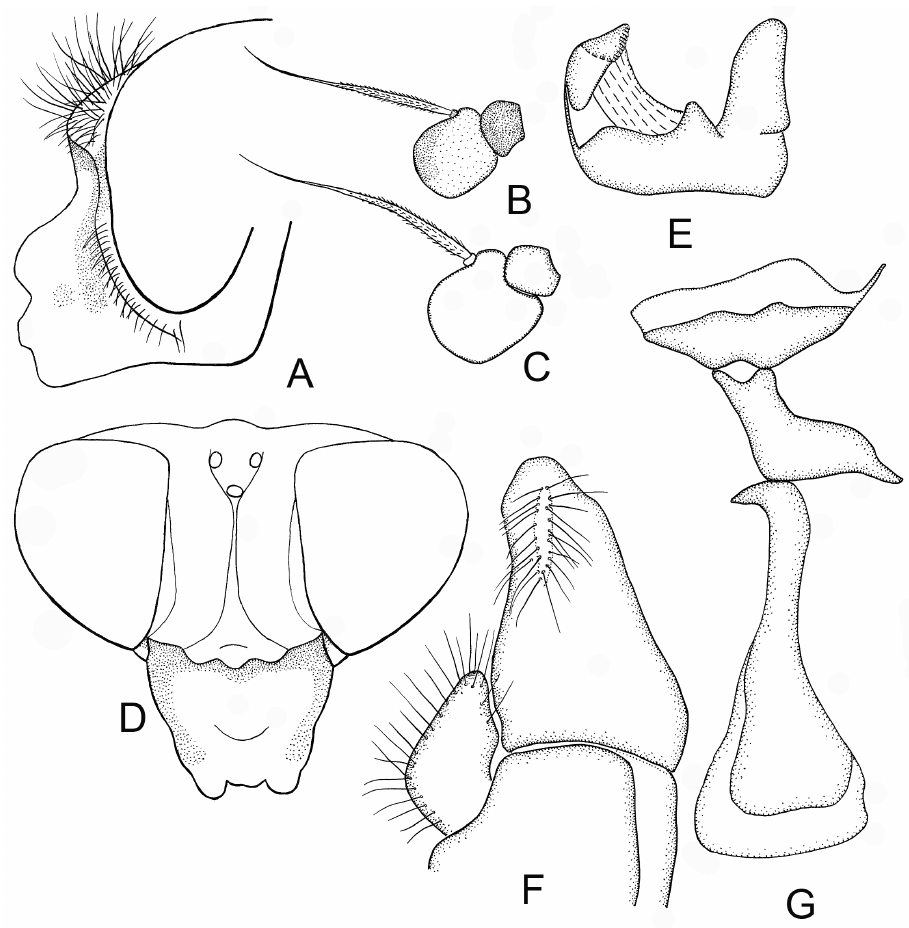
Figure 9. Cheilosia kerteszi Szilády. A Male head, lateral view B Antenna of male, lateral view C Antenna of female, lateral view D Head of female, dorsal view E–G male genitalia, lateral, from left to right: E Superior lobe F Cercus+surstylus G Aedeagal